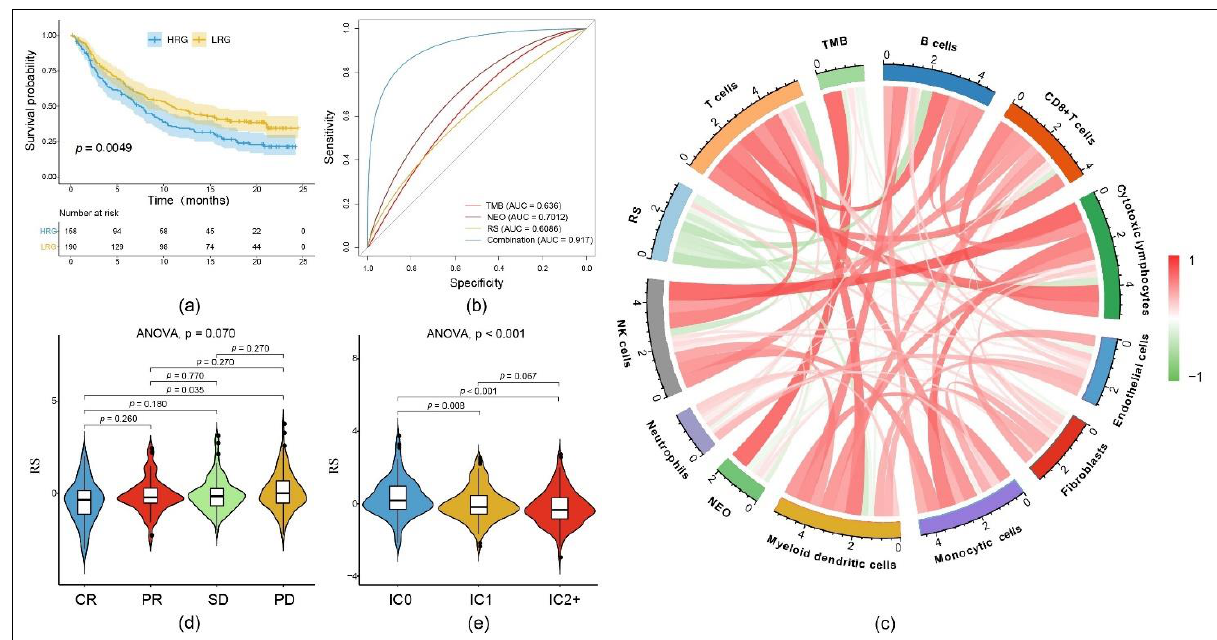
Figure 7. Prediction of potential immunotherapy using the RS in the IMvigor 210 cohort with human metastatic urothelial carcinoma samples from patients receiving programmed death ligand 1 (PD-L1) blocking immunotherapy: ( a ) The KM curve dividing the cohort into an HRG and an LRG according to the RS. ( b ) ROC curve for the prediction of treatment response to PD-L1 blocking therapy comparing tumor mutation burden (TMB), neoantigen (NEO), RS and the combination of all three. ( c ) Correlation between RS, immune cell score (IC-score), TMB and NEO. ( d ) RS according to the effectiveness of immunotherapy expressed as complete response (CR), partial response (PR), stable disease (SD) or progressive disease (PD). ( e ) RS according to different IC scores.